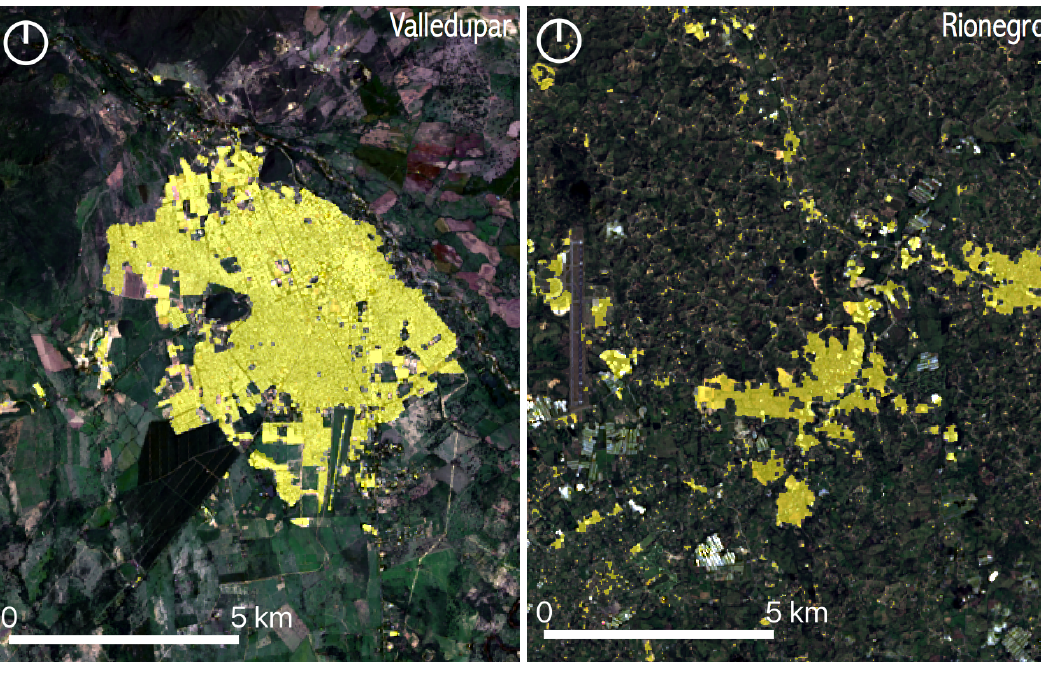
Figure 15. Results of the classification process of Landsat images of Valledupar and Rionegro into urban and non-urban areas for the year 2015. The yellow regions highlight the urban classification results.